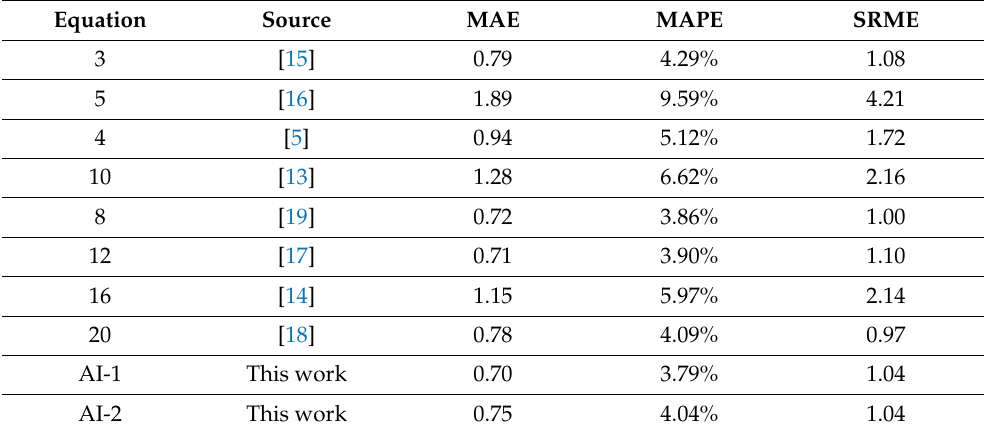
Table 11. Error table for equations based on proximate analysis.